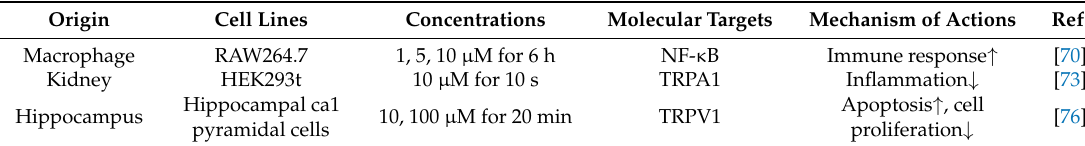
Table 3. Anti-inflammatory Effects of capsazepine in vitro .